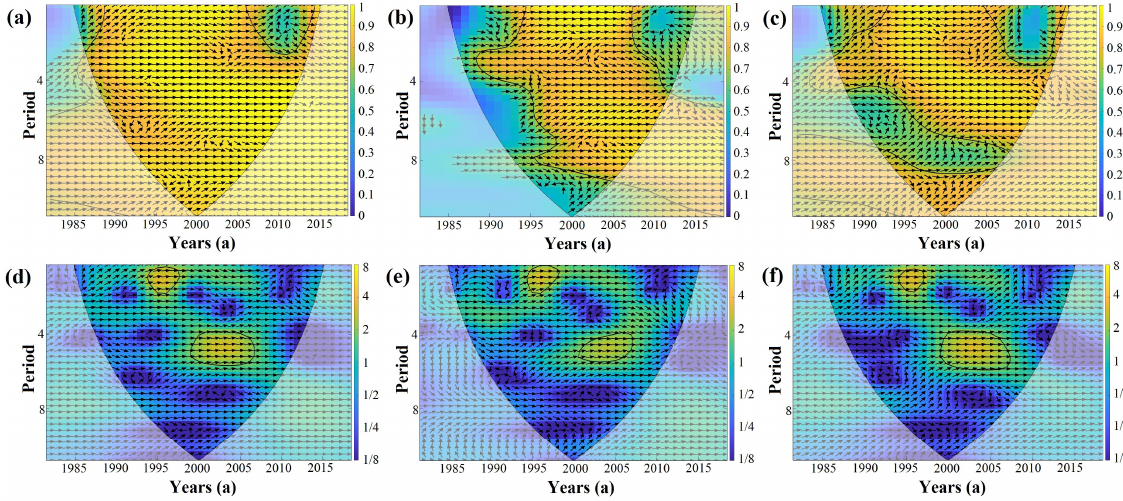
Figure 10. Wavelet coherency ( a – c ) and cross-wavelet spectrum ( d – f ) analysis of the relations between precipitation, runoff, TN, and TP loads in the TGRA.